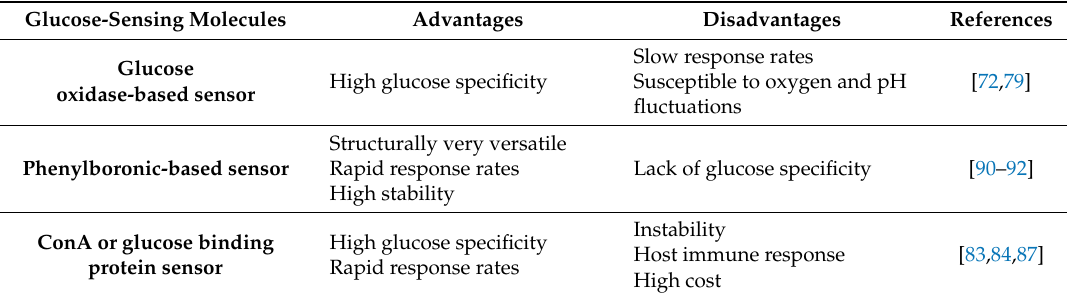
Table 3. Glucose-sensing molecules: advantages and